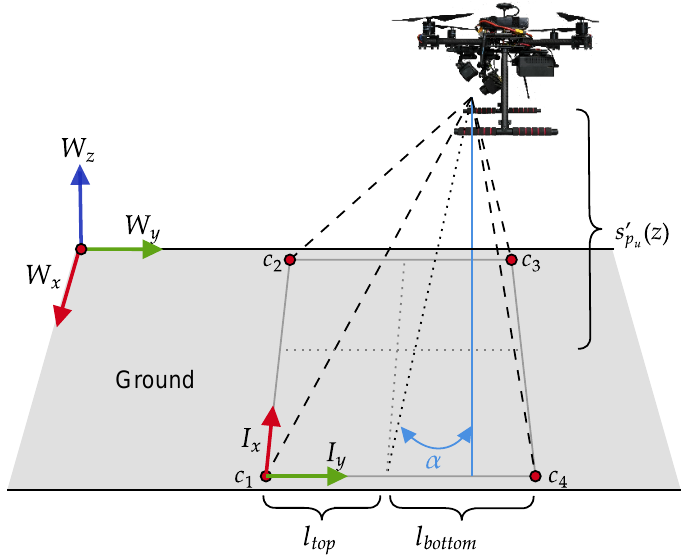
Figure 6. Field of view (FOV) projection and footprint extent of a vision-based sensor. The camera setup on the UAV frame defines α as the pointing angle from the vertical (or pitch) and determines the coordinates of the footprint corners c